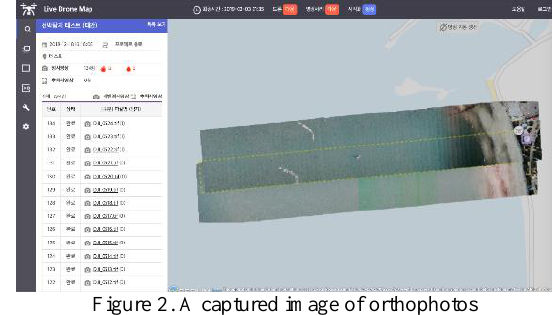
Figure 2. A captured image of orthophotos on Live Drone Map